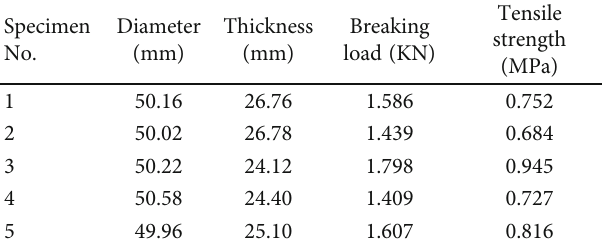
Table 2: Uniaxial tensile test results of X5